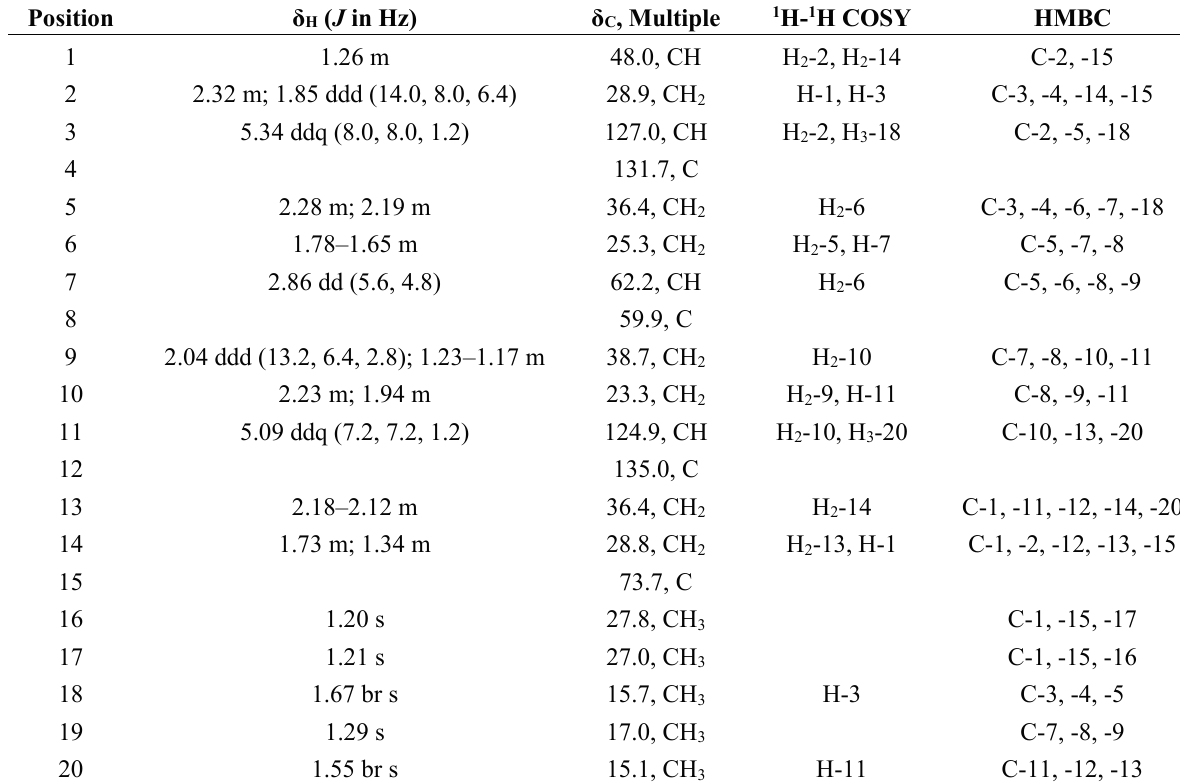
Table 3. 1 H (400 MHz, CDCl 3 ) and 13 C (100 MHz, CDCl 3 ) NMR data, 1 H- 1 H COSY and HMBC correlations for cembrane 3